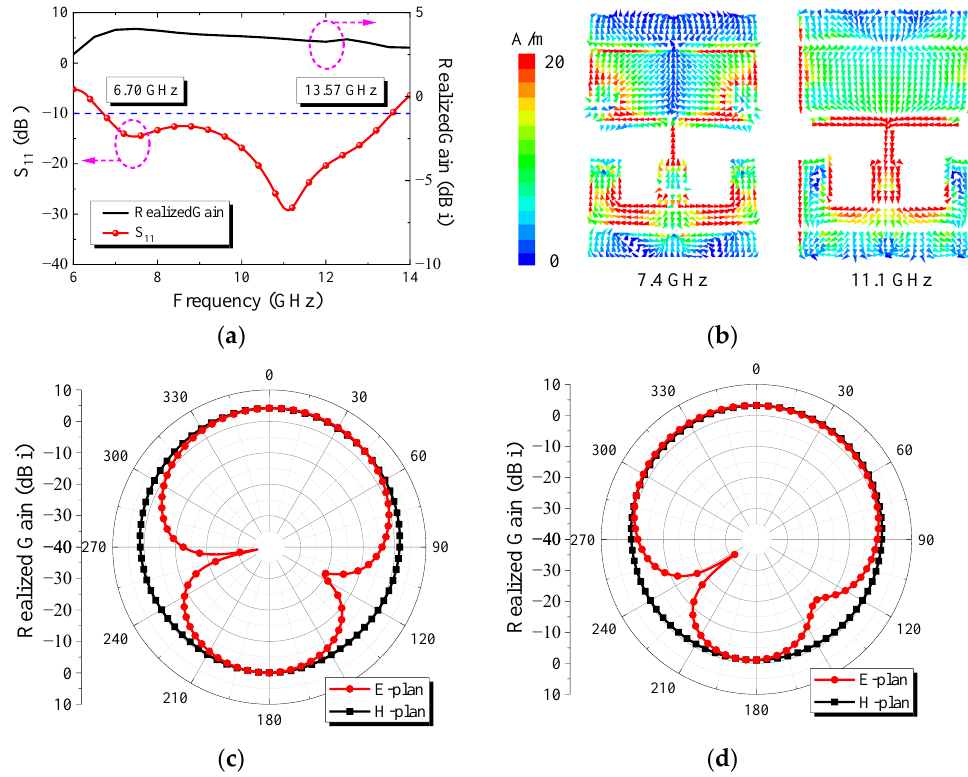
Figure 13. Simulation results of feed radiation performance: ( a ) curve of S 11 and realized gain; ( b ) surface current distribution at 7.4 GHz and 11.1 GHz; ( c ) radiation pattern at 7.4 GHz; ( d ) radiation pattern at 11.1 GHz.